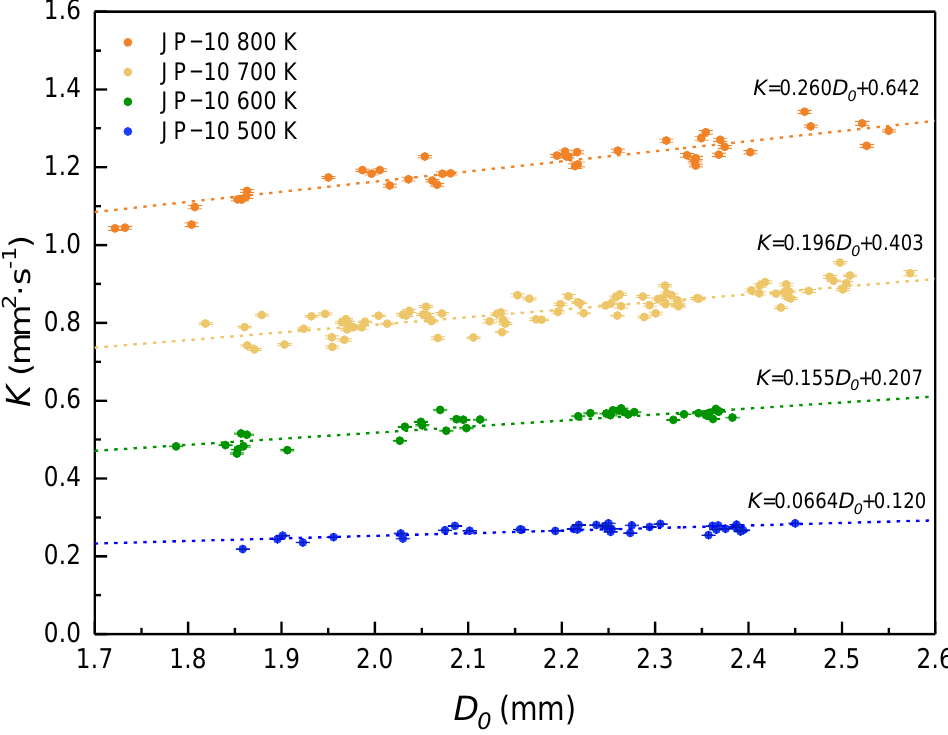
Figure 7. Variation in the evaporation constant K with initial droplet diameter D 0 at temperatures of 500–800 K. Error bars show the standard deviation.